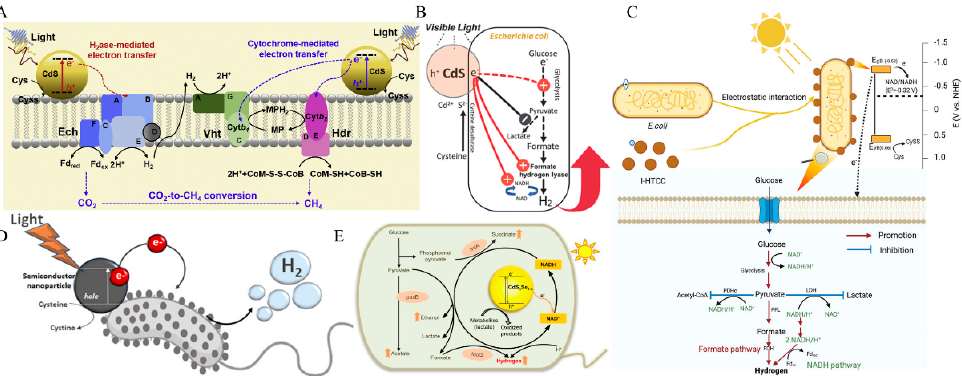
Figure 3. ( A ) Construction of M. barkeri -CdS biohybrid hybrid system could convert CO 2 to CH 4 .